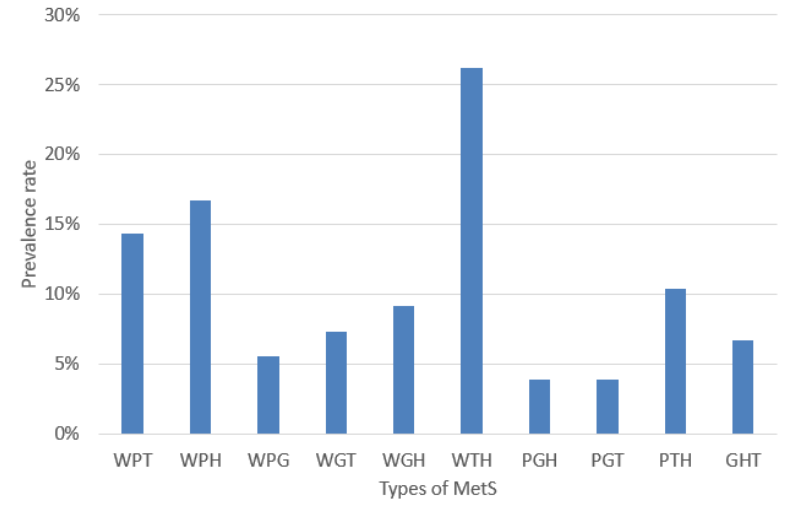
Figure 6. Prevalence rate of the MetS